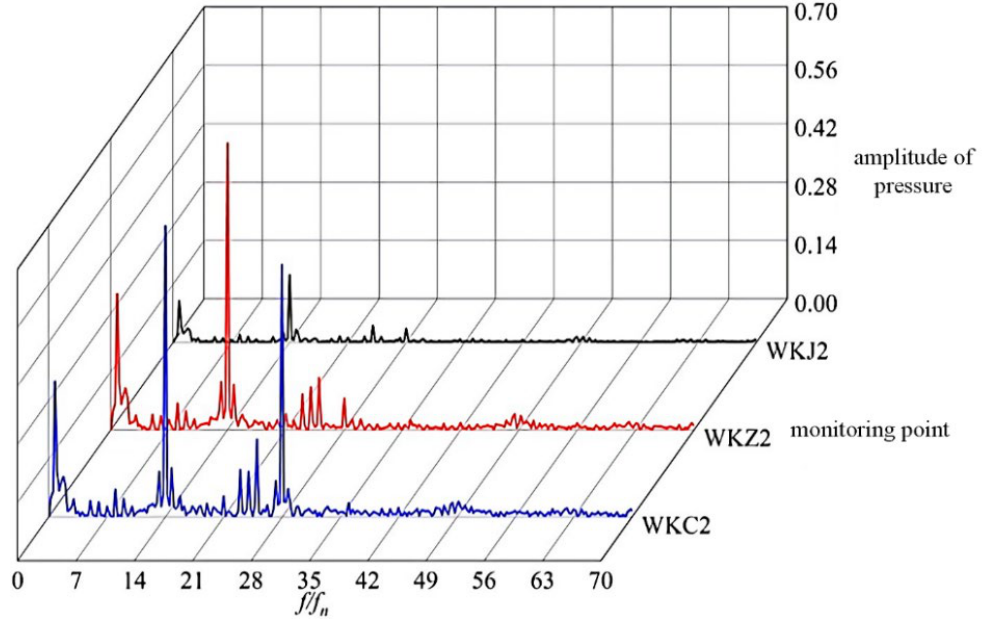
Figure 8. Frequency domain characteristics of pressure pulsation at monitoring points [40].